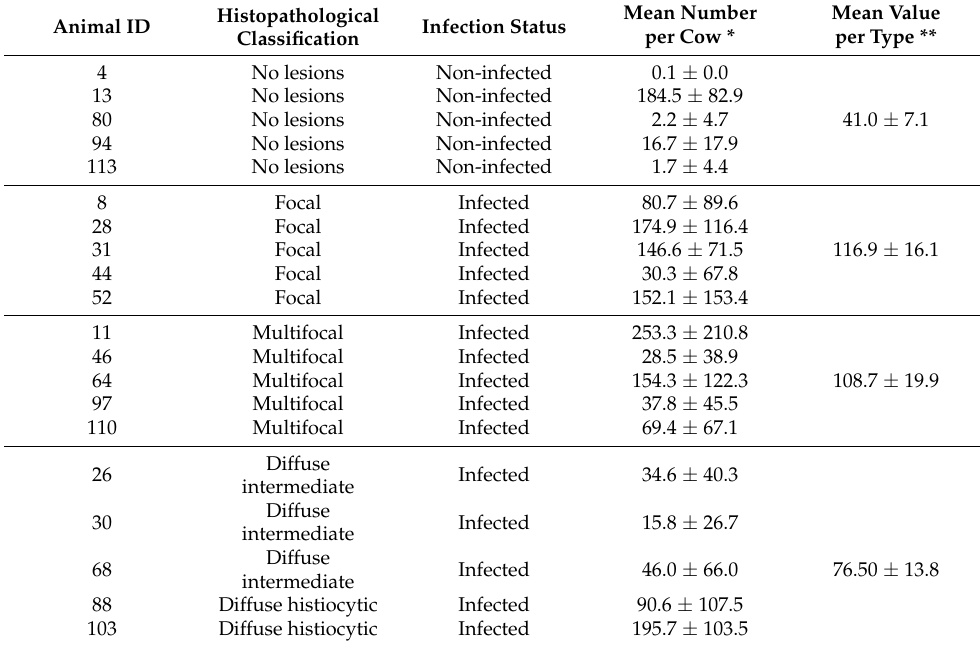
Table 2. Quantification of ITLN2-labelled cells present in the ICV samples of control animals with no lesions or animals with focal, multifocal and diffuse histological lesions.